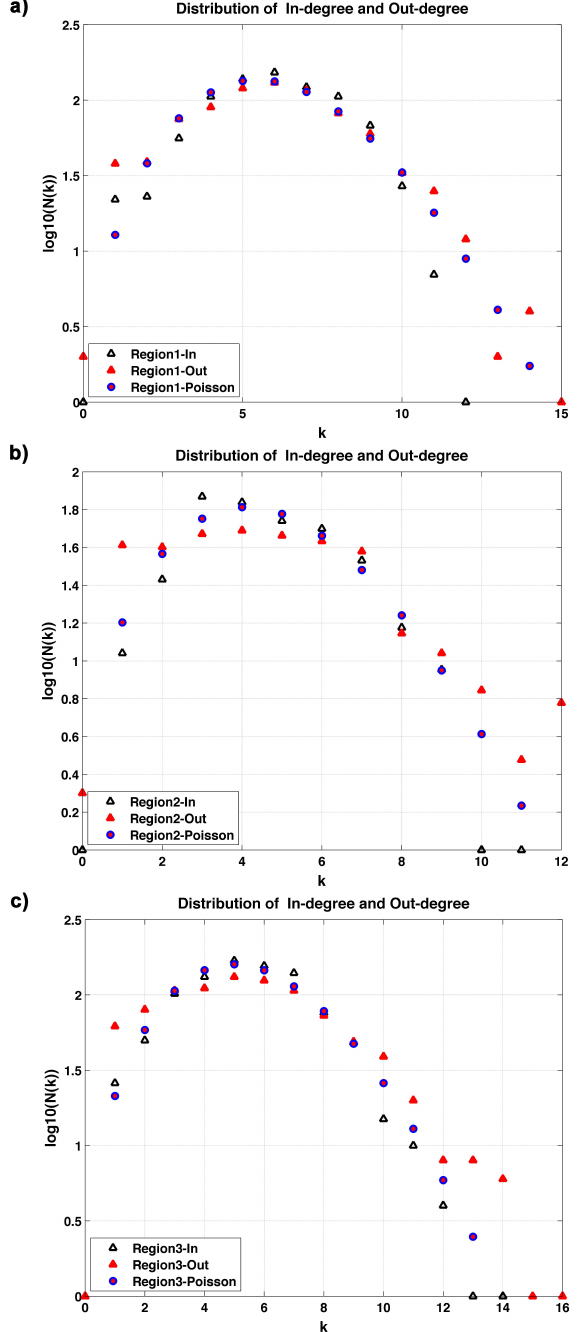
Fig. 4. In-degree and out-degree histograms for binary directed re- currence networks along with the Poisson probability distribution. (a) Region 1; (b) Region 2; (c) Region 3. The average degrees com- puted are 5.95, 4.61, and 5.47 for Region 1, Region 2, and Region 3, respectively for magnitude threshold of 2.